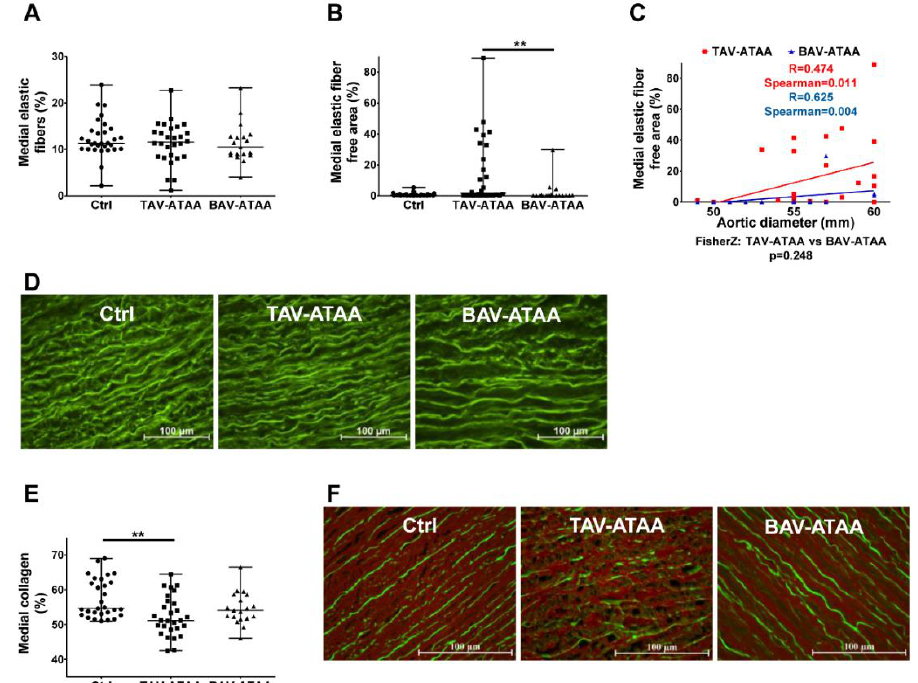
Figure 2. Focal degradation of elastic fibers in TAV- and BAV-associated aneurysms as well as TAV-associated loss of medial collagen amount. ( A ) shows the quantification of the content of elastic fibers relative to the total area in the aneurysmal aortas compared to the control tissue. In ( B ) the quantification of elastic fiber free areas is shown. Correlation analyses of aortic diameter with the elastic fiber free area are shown in ( C ). In ( D ) images show the auto-fluorescence properties of elastic fiber, which were used for quantification of elastic fiber content and elastic fiber free area (magnification 40 × ). ( E ) shows the quantification of the collagen content relative to the total area in the aneurysmal aorta compared to the control tissue (using the Sirius red stained tissue sections). ( F ) shows representative images of Sirius red stained medial tissue after fluorescence based detection of collagen (red) and viable tissue parts / elastic fibers (green) (magnification 40 × ). (Control n = 30; TAV n = 28; BAV n = 19) (** < 0.01).